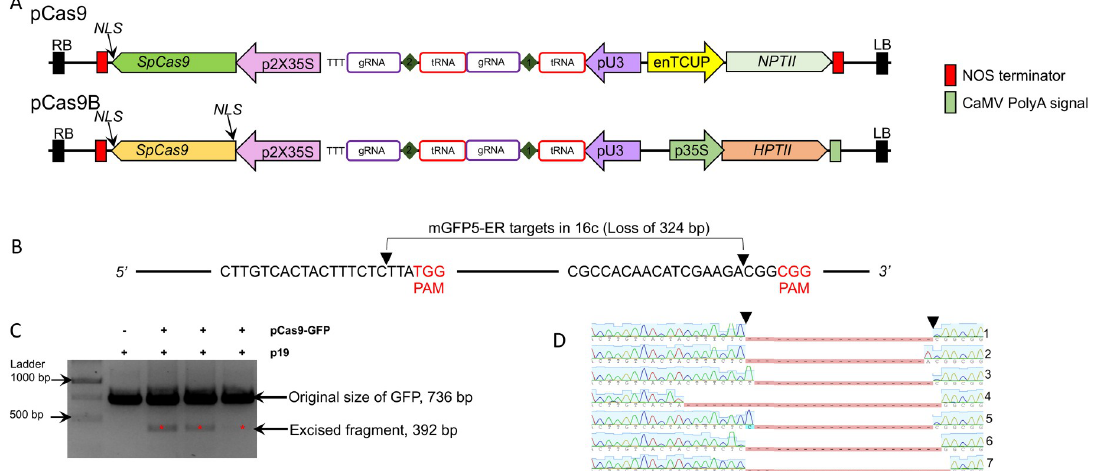
Fig 1. (A) Schematic of pCas9 plasmids used in this study. Although two gRNAs are shown for each construct only a single gRNA was used in the transient NanoLuc experiment. (B) Schematic mGFP5-ER sequence in transgenic 16c transgenic line used for CRISPR/Cas9 driven gene editing. The two target sites used for gRNA binding are shown and arrows show the predicted site of double strand break by SpCas9. (C) Gel image of PCR fragments of a representative leaf infiltrated with p19 and three other leaves infiltrated with pCas9-GFP and p19. The bands denoted with red asterisk on the image show evidence of dropout between the two gRNA target sites. (D) Sanger sequence trace of pGEM clones carrying the smaller PCR fragment (indicated with red asterisk in C ). The arrow indicates the region of Cas9 induced dsDNA